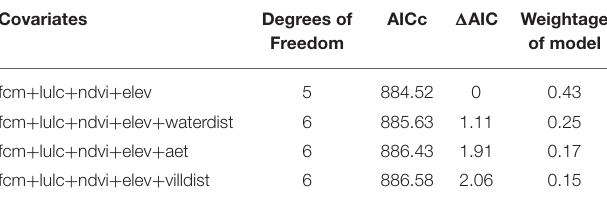
TABLE 1 | Result of generalized linear models used to evaluate the habitat use pattern of honey badger based on remotely sensed habitat covariates extracted around camera trap sites.